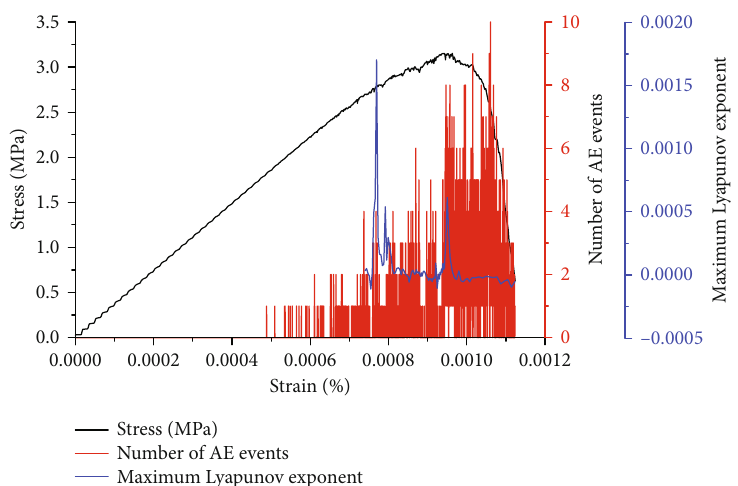
Figure 10: Stress-strain-number of AE events-maximum Lyapunov exponential variation diagram of specimen 7.